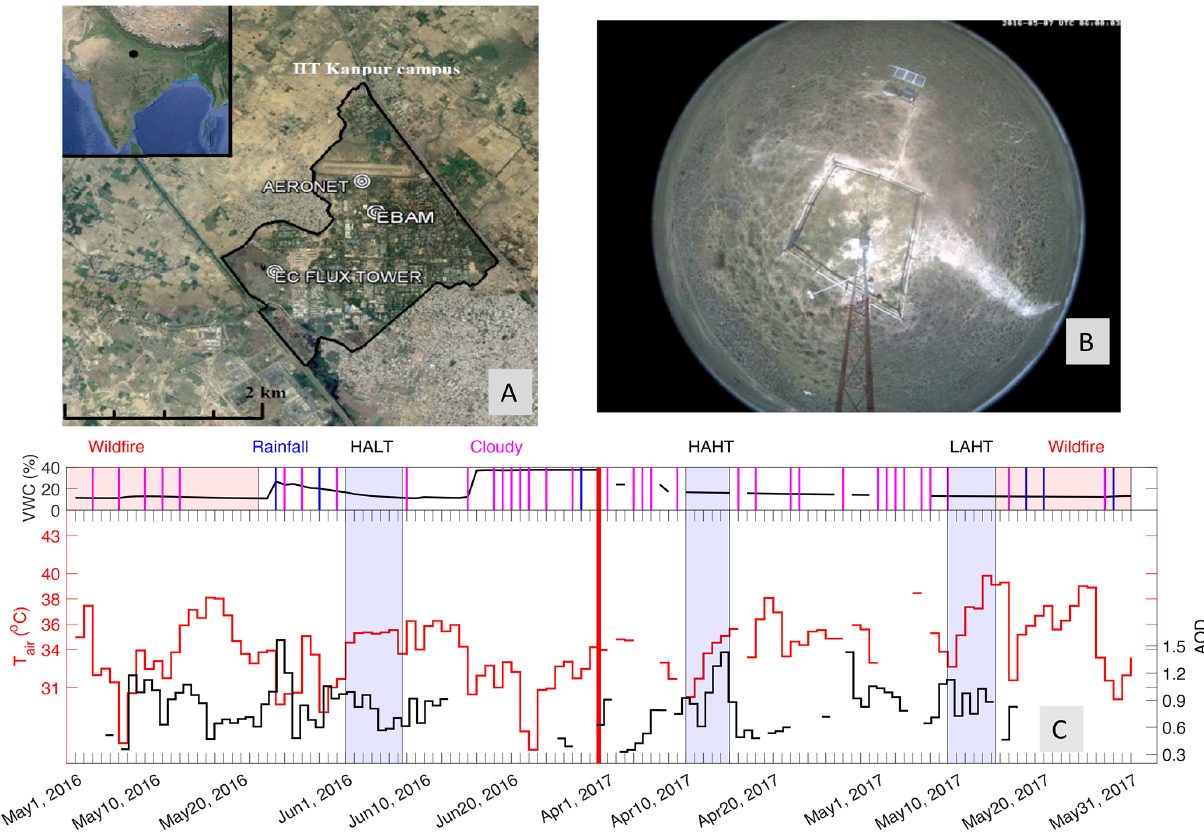
Figure 1. (a) Map showing the locations of AERONET and the eddy covariance (EC) flux tower site within the campus of the Indian Institute of Technology Kanpur (IITK). The inset map shows the location of IITK (black dot) in the central Gangetic Plains. The maps are created by © Google Maps 2017. (b) Camera image of the and cover of the flux tower site during 12 May 2017. (c) The daily variation in soil moisture (VWC – volumetric water content) during our study period is shown as a black line in the upper box of the panel. The occurrences of cloudy days, rainy days, and the wildfire-affected period during April through June 2016 and 2017 is shown by magenta, blue, and pink color patches in the upper box. A cloudy day is inferred from NASA Micro-Pulse Lidar Network (MPLNET) images and AERONET observations (as defined in Sect. 2). The days bounded by straight lines depict the weekly episodes of high AOD–low T air (HALT), high AOD–high T air (HAHT), and low AOD–high T air (LAHT), respectively. Daily variation in T air and daily variation in AOD during our study period is shown as black and red lines in lower box of the